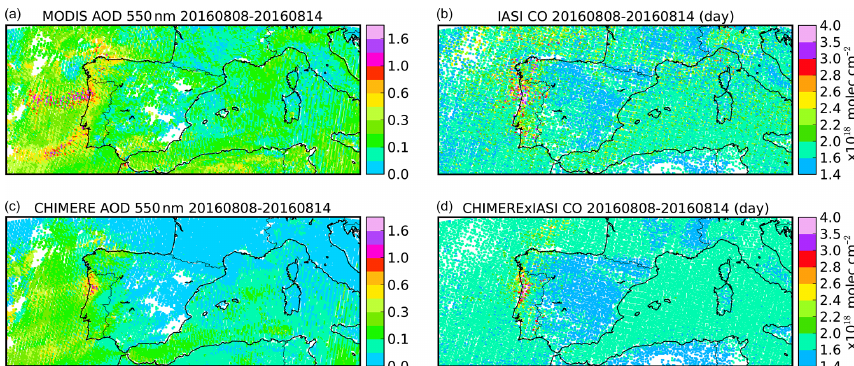
Figure 14. (a–b) Observations of AOD at 550nm by MODIS and CO total column by IASI during the fire event in Portugal between 8 and 14 August 2016, averaged onto the CHIMERE grid at 10km horizontal resolution. (c–d) Corresponding CHIMERE values (smoothed by IASI averaging kernels for CO) for the BA-sf-MISR experiment.